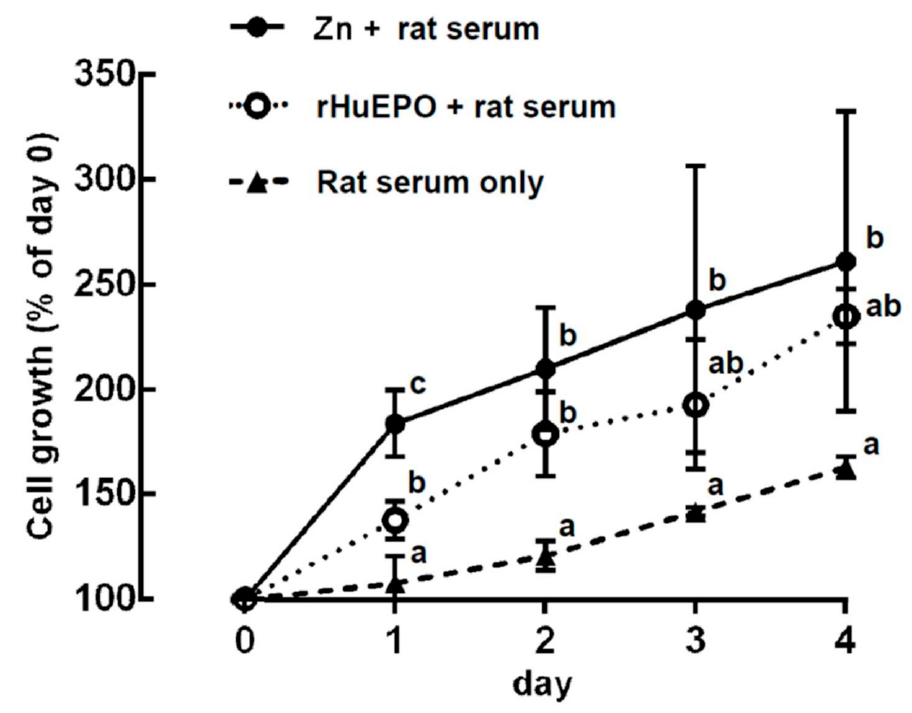
Figure 7. Comparison of cell growth induced using ZnCl 2 or rHuEPO supplementation in rat bone marrow cells. Rat bone marrow cells were cultured in a suspension in medium with serum only, 0.3 mM ZnCl 2 + serum, or 600 pg/mL rHuEPO + serum for 4 days. At each day, cell size and number of harvested cells were measured as shown in Figure 6. The cell growth is expressed as the ratio of the number of 5.1-µm cells at the start of the culture compared with that of the controls. a, b, c: Significant difference ( p < 0.05, n = 6) among different experimental groups on the same day. The data presented are from one representative experiment of three independent experiments.